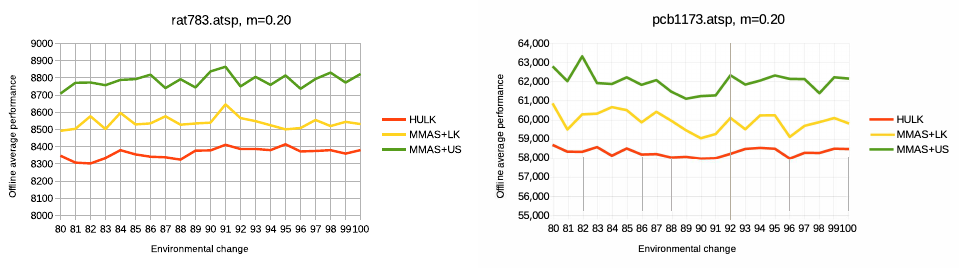
Figure 5. Dynamic average offline performance of the presented methods for symmetric DTSPs with m = 0.2.